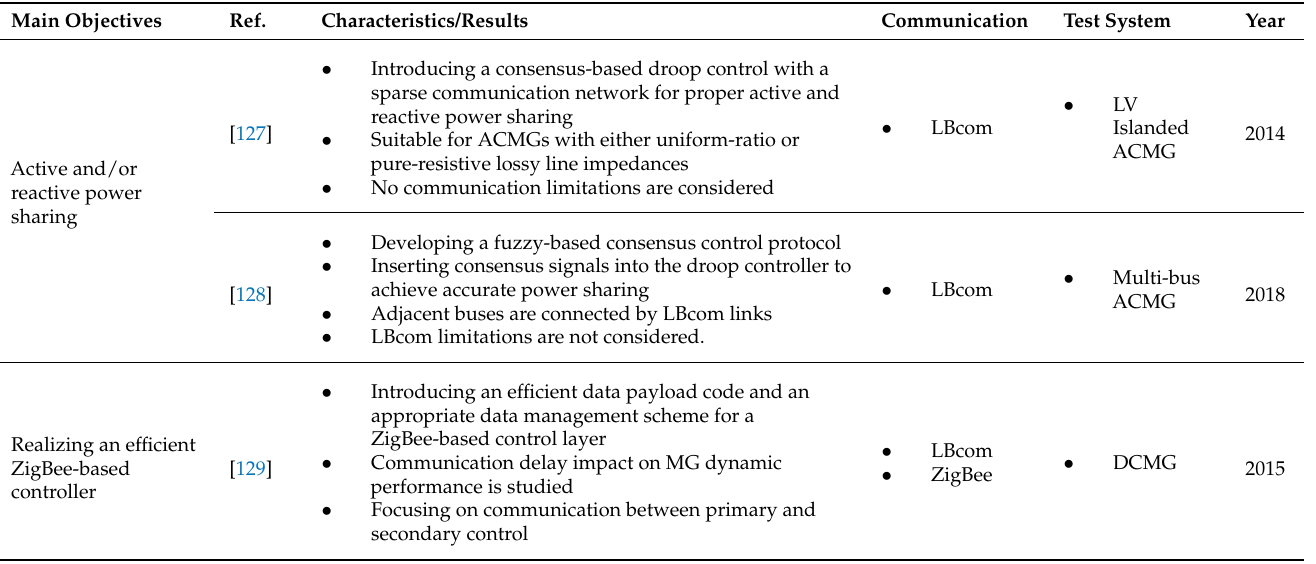
Table 15. Summarizing and categorizing LBcom-network-based control methods with more than one control